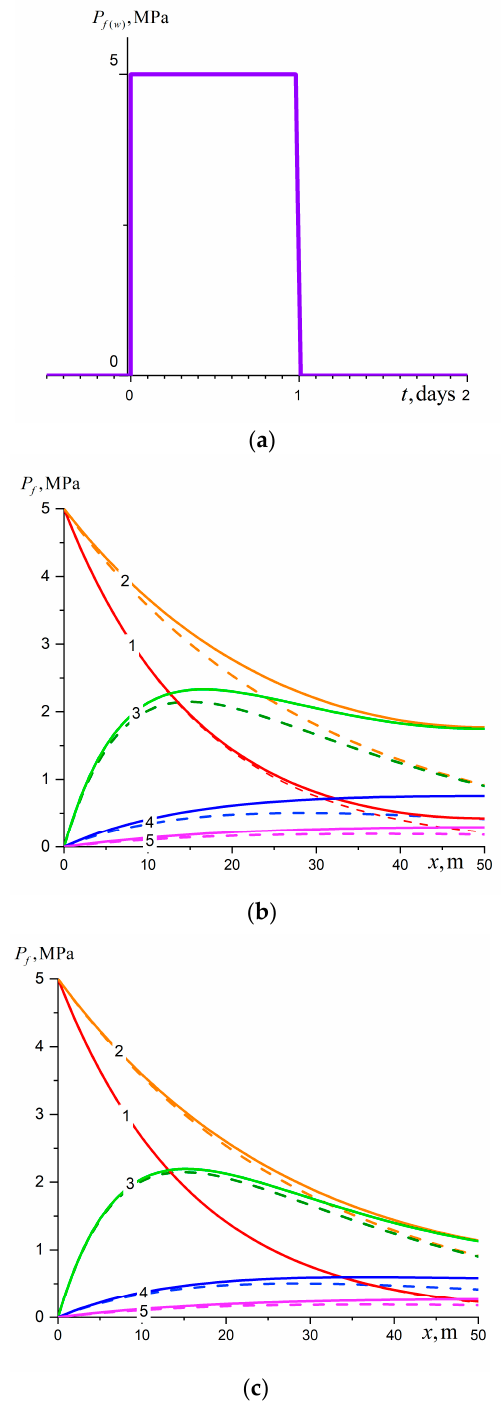
Figure 4. ( a ) two-stage pressure change; ( b ) pressure change in a 50 m long fracture; ( c ) for a fracture 70 m long. Solid lines—according fracture. 1—2 h, 2—1 day, 3—1 day 10 min, 4—1.5 days and 5—3 days.